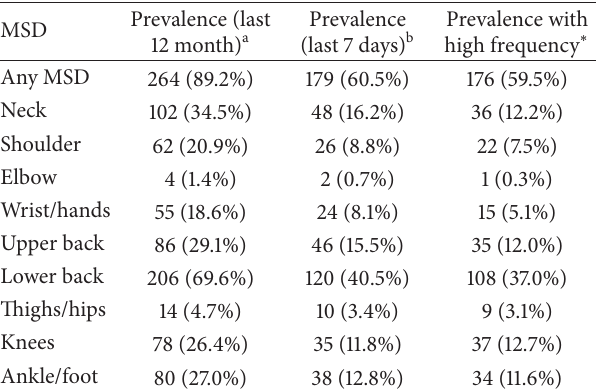
Table2:PrevalenceofdifferenttypesofMSDoverthelast12months and last 7 days and with high frequency.